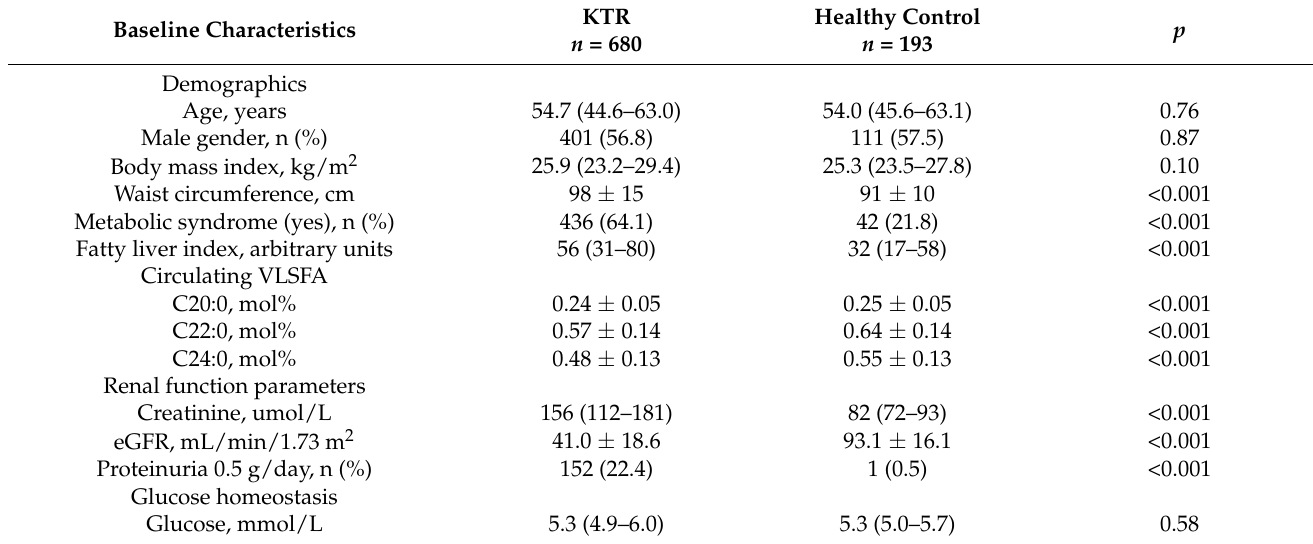
Table 1. Baseline characteristics of KTR and healthy